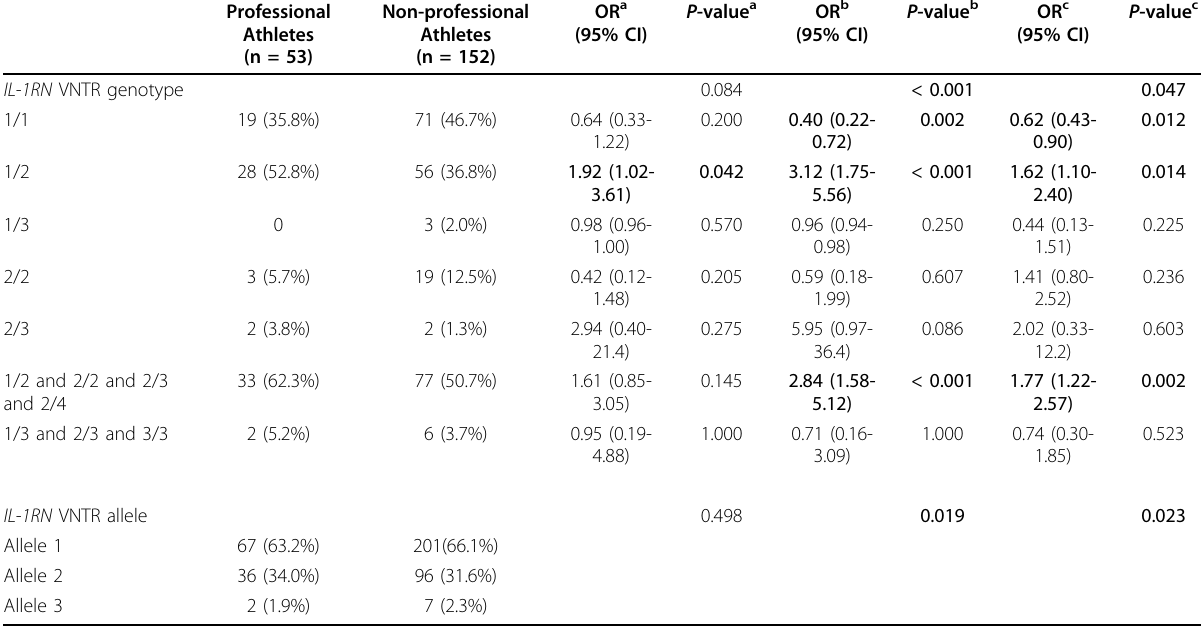
Table 5 Genotype frequencies of IL-1RN VNTR comparison of 53 professional athletes and 152 non-professional athletes and 458 non-athlete controls